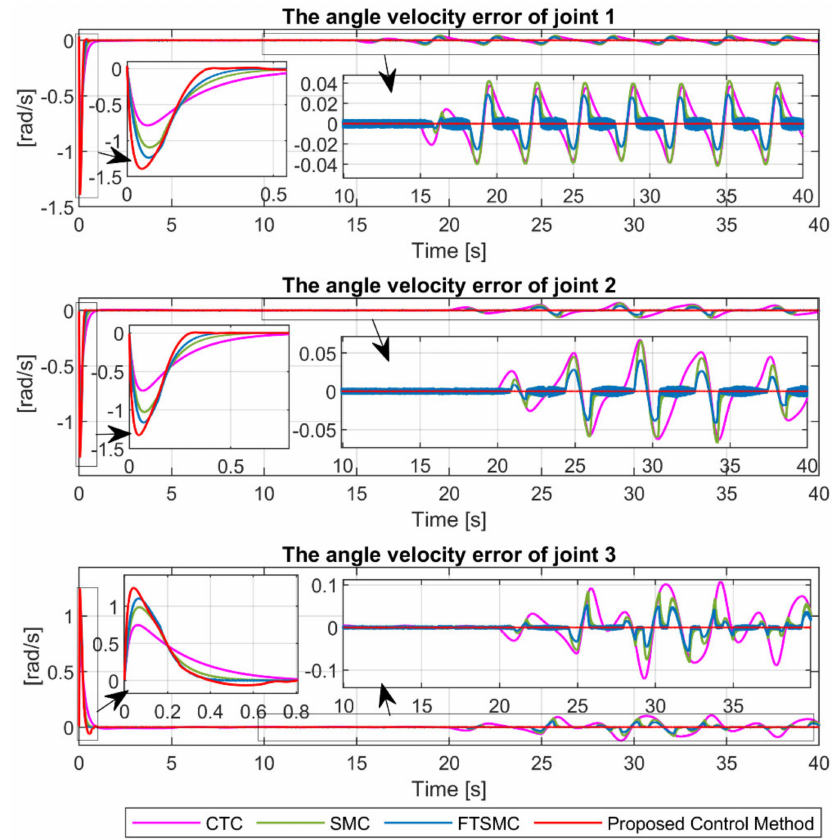
Figure 11. The tracking velocity errors of joint 1, joint 2, and joint